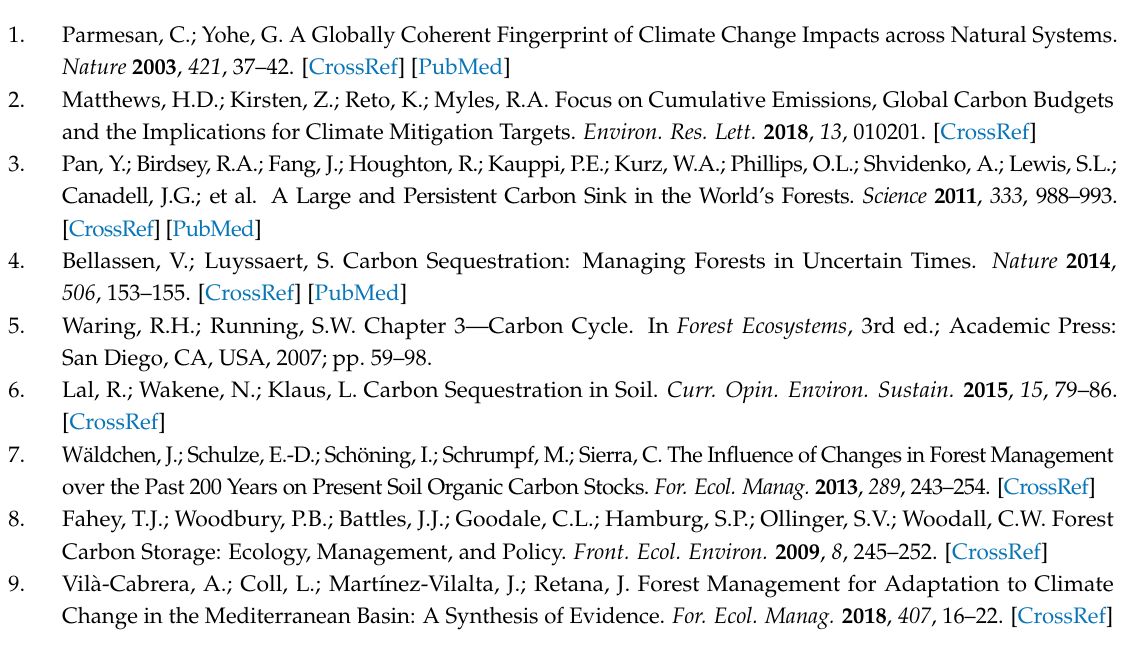
plots used in the study and the thinning square area is indicated by yellow line, Figure S2. Variable importance classification of the non-collinear selected variables. Label legends according to Table 3: variables selected to perform model predictions A to D. Figure S3. Bivariate relationships between the LiDAR metrics and SOC 40 (0–40 cm soil layer) C stock of Pinus halepensis plantations at Los Cuadros (Murcia, Spain). In all figures the linear 1:1 line has been fitted. For these equations the R 2 value is included (see Table 3 for RMSE values). Figure S4. Bivariate relationships between the LiDAR metrics and biomass + SOC 40 (0–40 cm soil layer) C stock of Pinus halepensis plantations at Los Cuadros (Murcia, Spain). In all figures the linear 1:1 line has been fitted. For these equations the R 2 value is included (see Table 3 for RMSE values). Table S1. Silvicultural characteristics of the inventory plots (N = 83) used in LiDAR models of carbon stocks of Pinus halepensis plantations at Los Cuadros (Murcia, Spain, see Figure S1). Variables and abbreviations: stem density (D); height (H); diameter at breast height (dbh); basal area (G); overall biomass (Wt), Table S2. Correlation coefficients describing the strength of the linear relationships between the stand metrics (mean height, mean diameter, basal area, stand density, and biomass) obtained with LiDAR and the measured stand metrics, Table S3. The C stock values obtained from LiDAR models of Pinus halepensis plantations at Los Cuadros (Murcia, Spain, see Figure S1). Variables and abbreviations: biomass (W t -S), soil organic carbon stock (0–10 cm soil layer) (SOC-S 10 ), soil organic carbon stock (0–40 cm soil layer) (SOC-S 40 ), biomass and soil organic carbon stock (0–10 cm soil layer) (W t -S, SOC-S 10 ), and biomass and soil organic carbon stock (0–40 cm soil layer) (W t -S, SOC-S 40 ). All values are expressed in Mg ha − 1